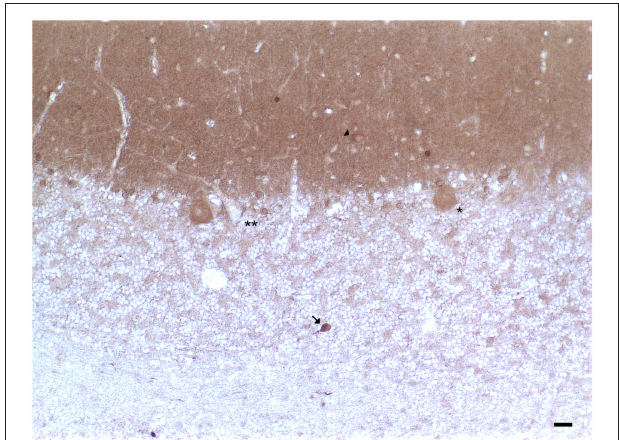
FIGURE 1 | Dopamine transporter (DAT) immunoreactivity in the cerebellar cortex. The DAT immunoreactivity is detectable in neuronal bodies and processes of all the layers of the cerebellar cortex. In the molecular layer, DAT immunoreactivity in basket neurons ( arrowheads ); primary and secondary trunks dendritic and apical dendrites of Purkinje neurons; immunonegative stellate neurons, fine clusters of DAT immunoreactivity in the neuropil of the layer. In the Purkinje neuron layer, DAT immunoreactive Purkinje neuron cell body ( single asterisk ), DAT immunonegative Purkinje neuron ( double asterisk ). In the granular layer, DAT immunoreactivity in space of Held, DAT immunoreactivity in the cell body, and axon-like processes of the synarmotic neuron ( arrow ). (Scale bar: 25 µ m).